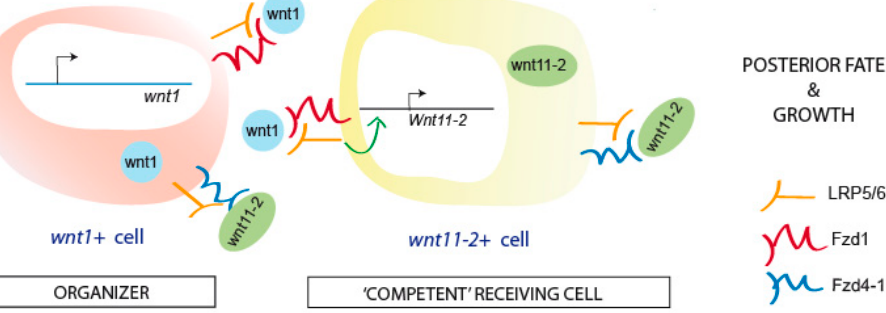
Figure 5. Model of how FZD and LRP5/6 receptors could be receiving the cWNT signal in the organizer ( wnt1+ ) and in the receiving cells ( wnt11-2+ ) to specify the fate and promote growth of the posterior wound during planarians regeneration.